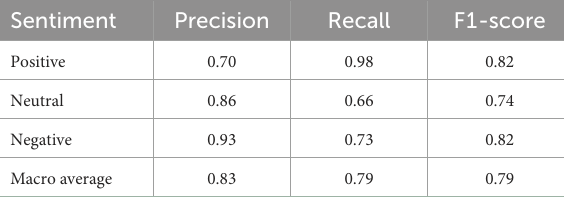
TABLE 1 Performance metrics of the algorithm in terms of sentiment classification.